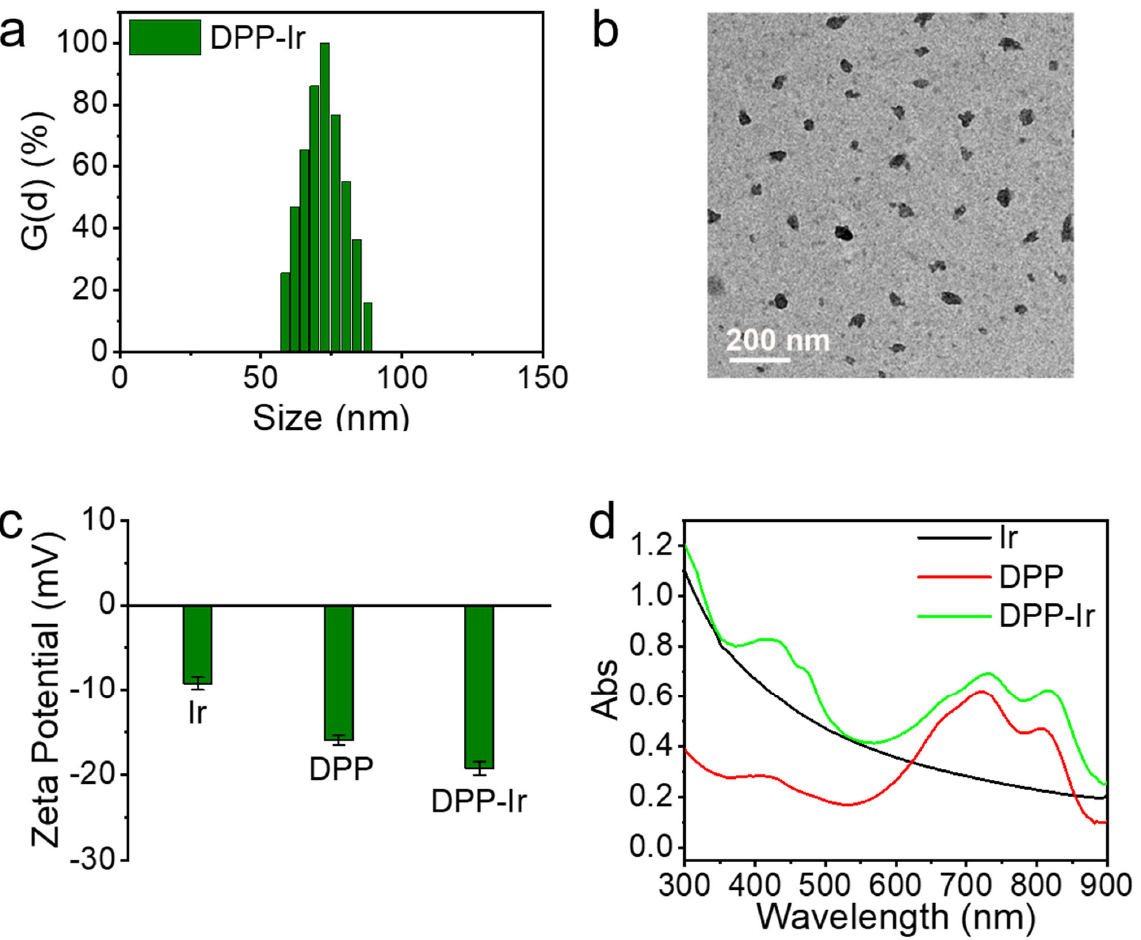
Figure 1. ( a ) Size distribution of DPP ‐ Ir nanoparticles. ( b ) TEM image of DPP ‐ Ir nanoparticles. ( c ) Zeta potential of indicated nanoparticles. ( d ) Absorption spectra of three nanoparticles in water.